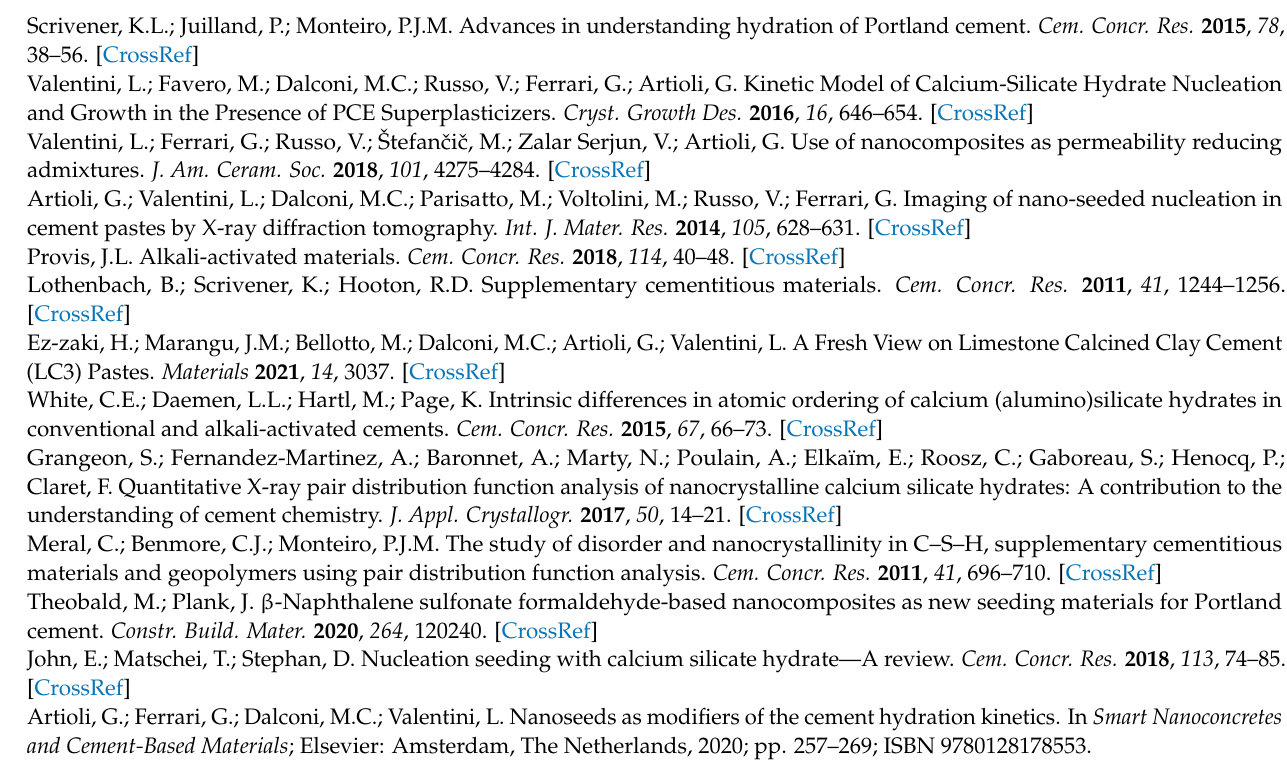
Figure S3: Normalized XANES spectra of the Me-S-H/PCE sample measured as colloidal suspension and dried powder; Table S1: model parameters used in SAXS and WAXTS analyses; Table S2: Refined site occupancy (s.o.f.) and Debye-Waller B factors for each atomic species obtained from the best fit